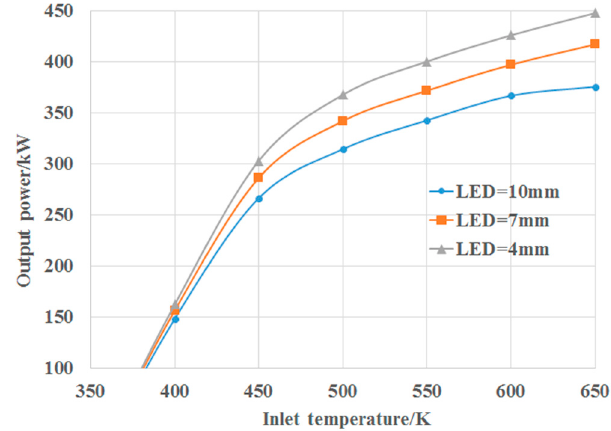
Figure 15. Correlation of inlet temperature towards output power.